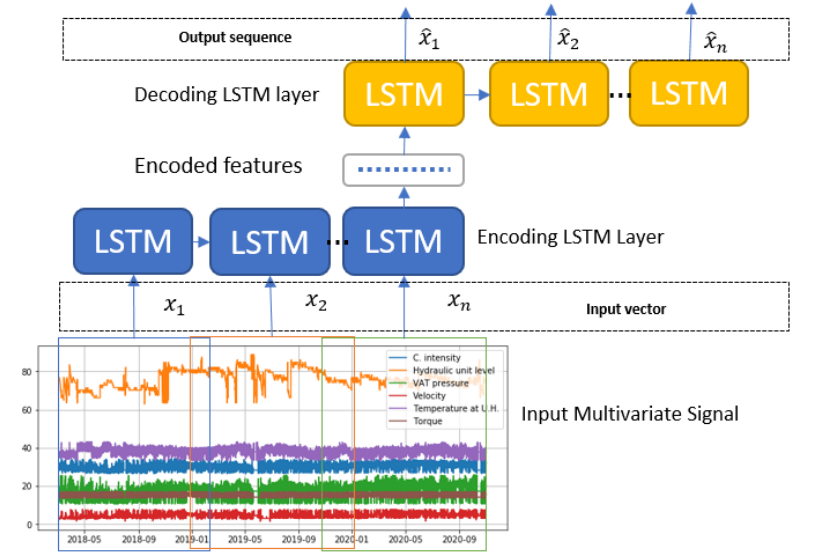
Figure 8. Base architecture of the LSTM model